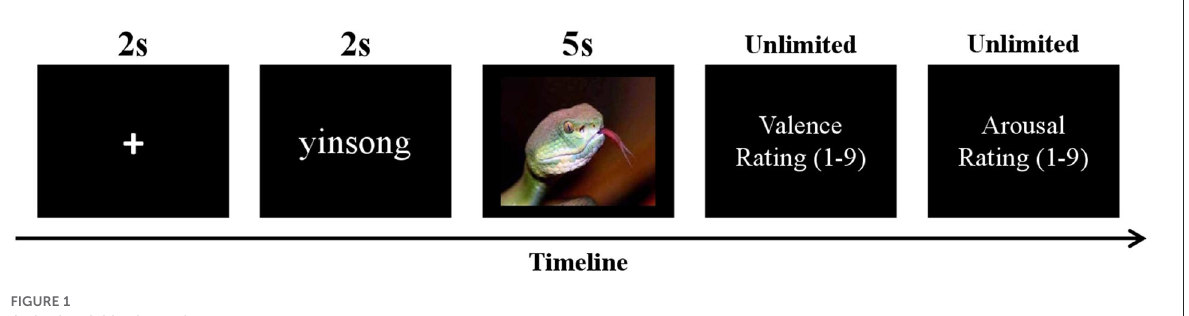
FIGURE1 A single trial in the task.